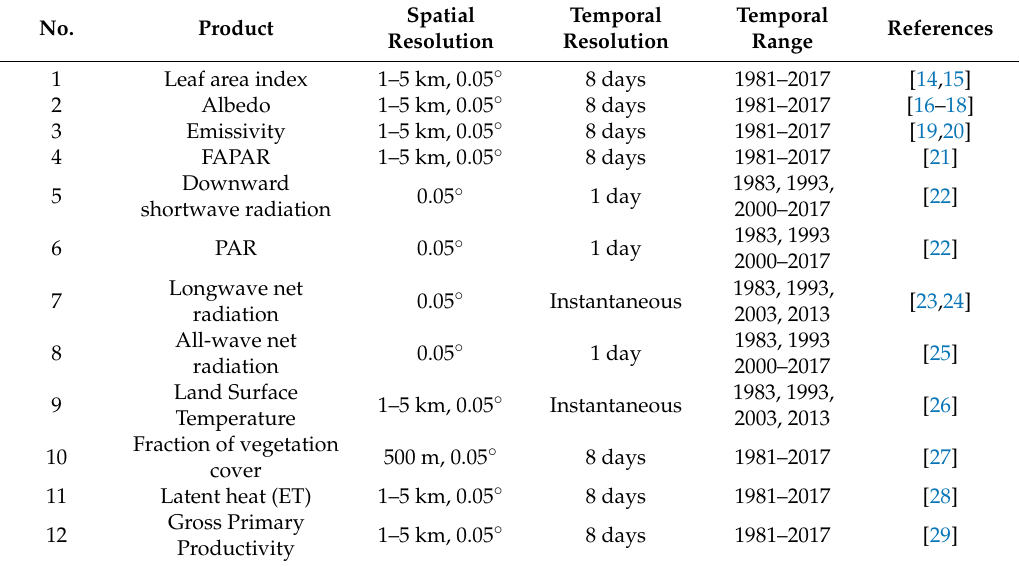
Table 1. Overview of the Global Land Surface Satellite (GLASS) products and their characteristics.